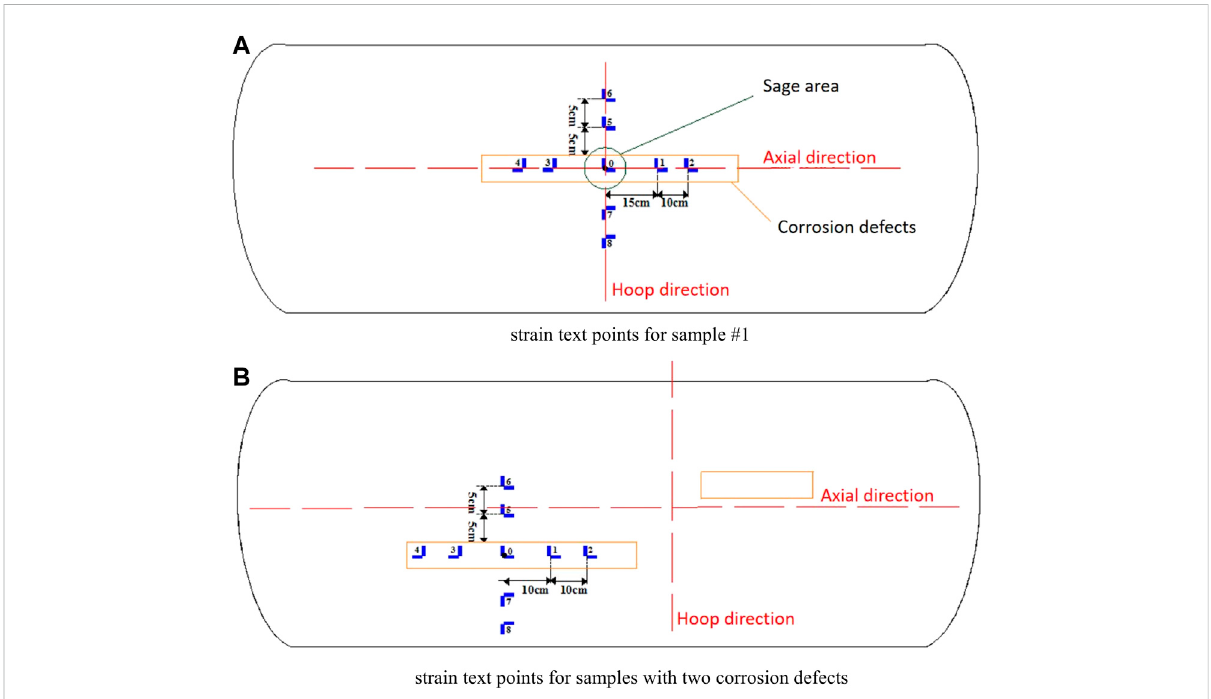
FIGURE 4 Nine strain test points around the defect on test samples, where (A) shows the strain test points for sample #1, and (B) shows the strain test points for samples with two corrosion